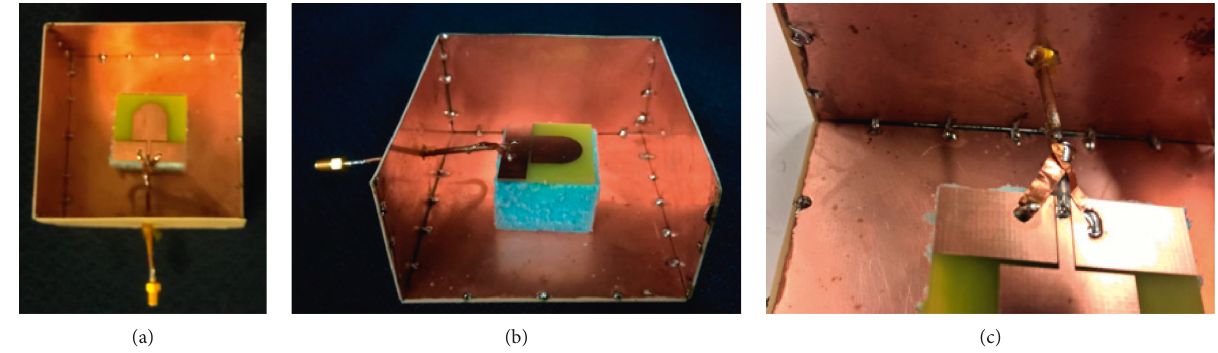
Figure 6: Prototyped cavity-backed antenna. (a) Top view. (b) Side view. (c) Zoom on the feed point.